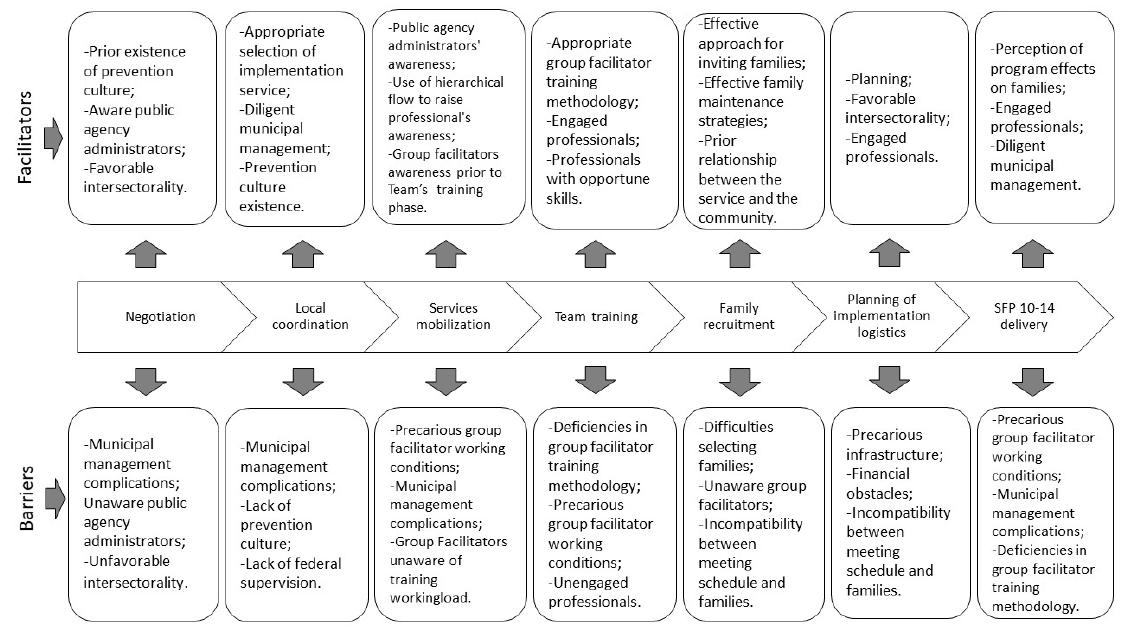
Figure 3. The most recurrent barriers and facilitators over the course of the preimplementation and implementation process of SFP 10–14 in Brazil.